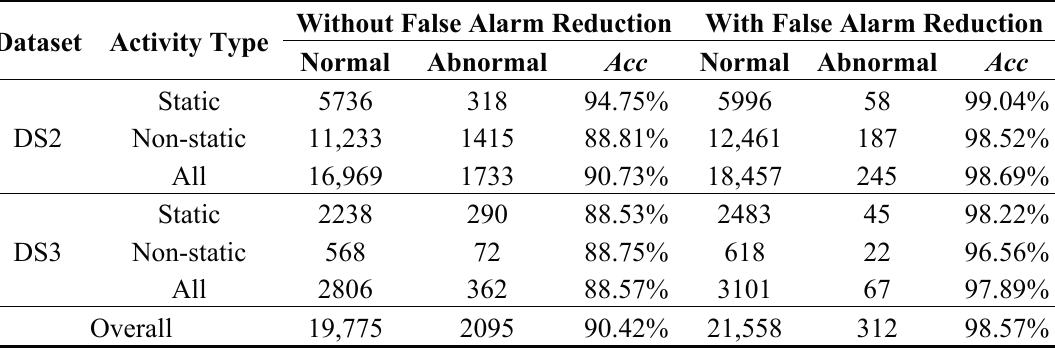
Table 13. Arrhythmia classification results after false alarm reduction on DS2 and